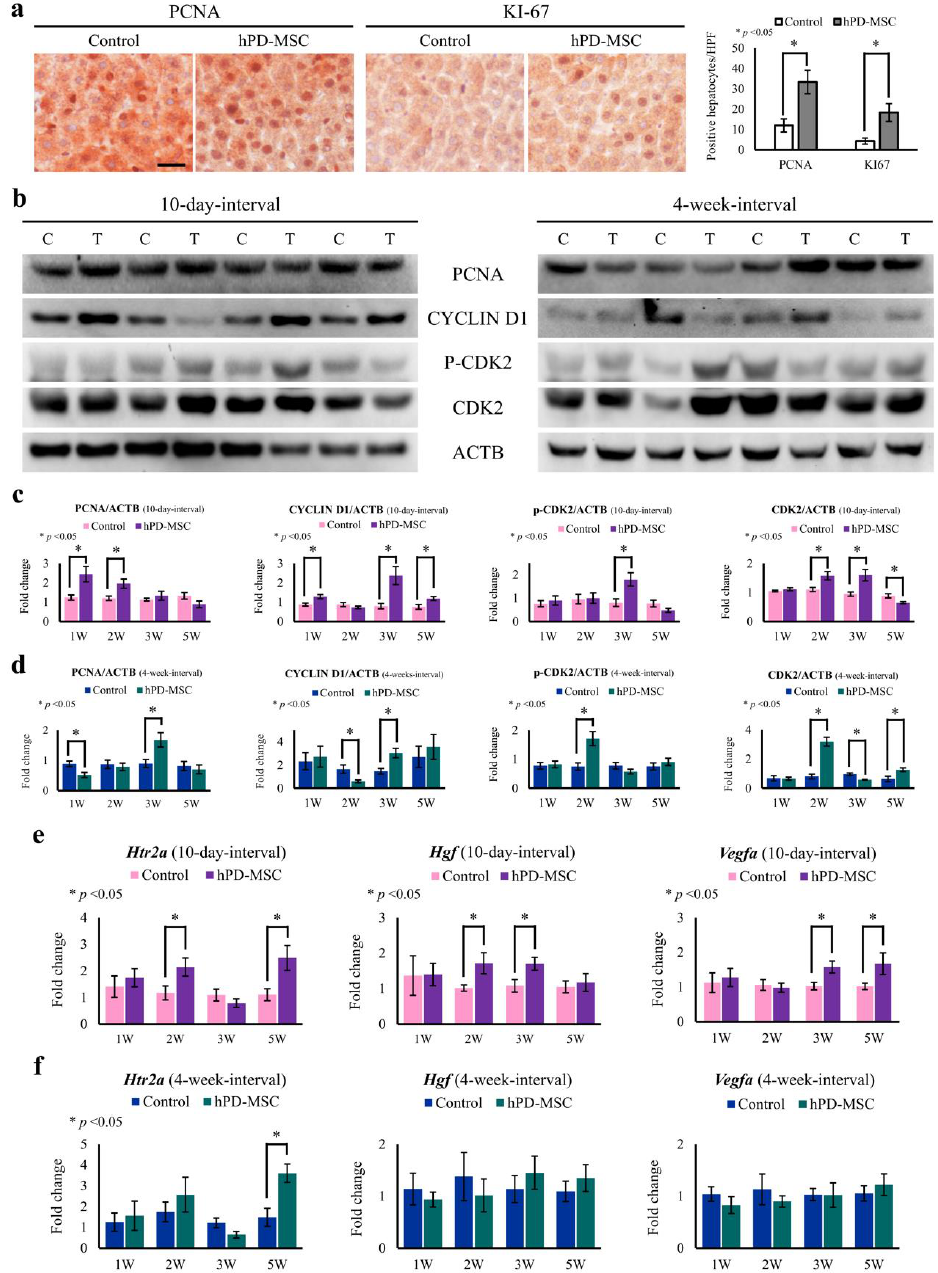
Figure 4. Enhanced hepatocyte proliferation by multiple-injection hPD-MSC therapy can delay liver aging. ( a ) Proliferation of hepatic cells assessed by quantification of immunostaining for the proliferation markers Ki-67 and PCNA in liver specimens after stem cell therapy in advanced-age rat models. Cells were counted in six different sections, and the data are expressed as the number of Ki-67- or PCNA-positive cells ± SEM. The asterisk represents statistical significance at p < 0.05. The scale bar indicates 25 μ m. ( b ) The levels of the hepatic proteins PCNA, CYCLIN D1, p-CDK2, and CDK2 were evaluated using Western blot analysis at 10-day intervals or 4-week intervals. ACTB was used as a loading control. C, control group; T, multiple-injection hPD-MSC therapy group. ( c , d ) Bar graph represents the band intensity of each marker normalized to the intensity of the respective ACTB band at 10-day intervals ( c ) or 4-week intervals ( d ). Data are presented as the mean ± SEM. The asterisk represents statistical significance at p < 0.05. Control, PBS-injected group; hPD-MSCs, multiple-injection hPD-MSC therapy group. ( e , f ) Changes in the expression of genes related to hepatocyte proliferation in the liver were evaluated by qRT–PCR after multiple injections of hPD-MSC therapy at 10-day intervals ( e ) or 4-week intervals ( f